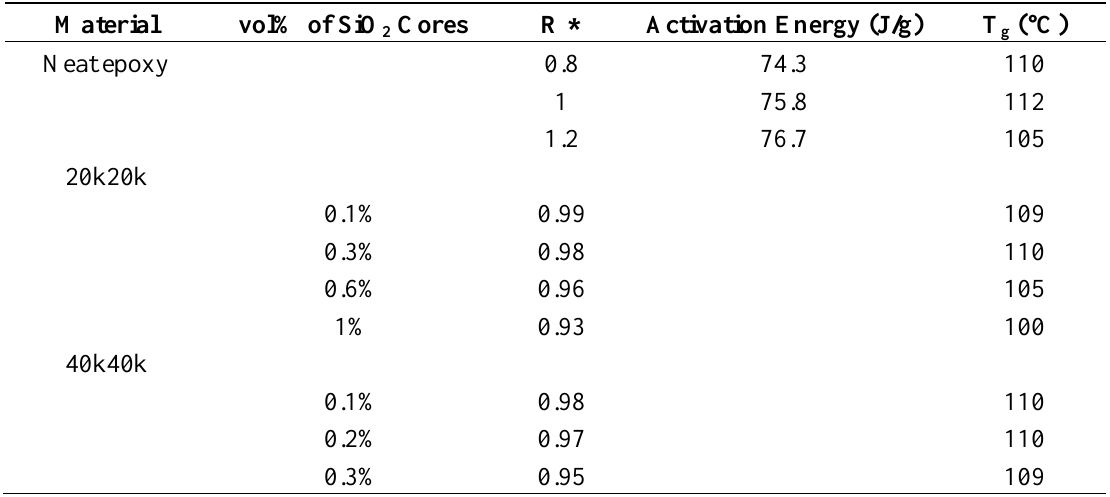
Table 2. The glass transition temperature of the epoxy systems.